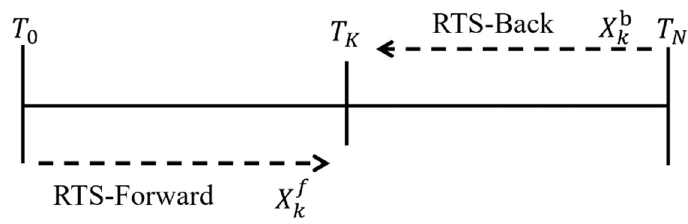
Figure 9. RTS smoothing algorithm flow.